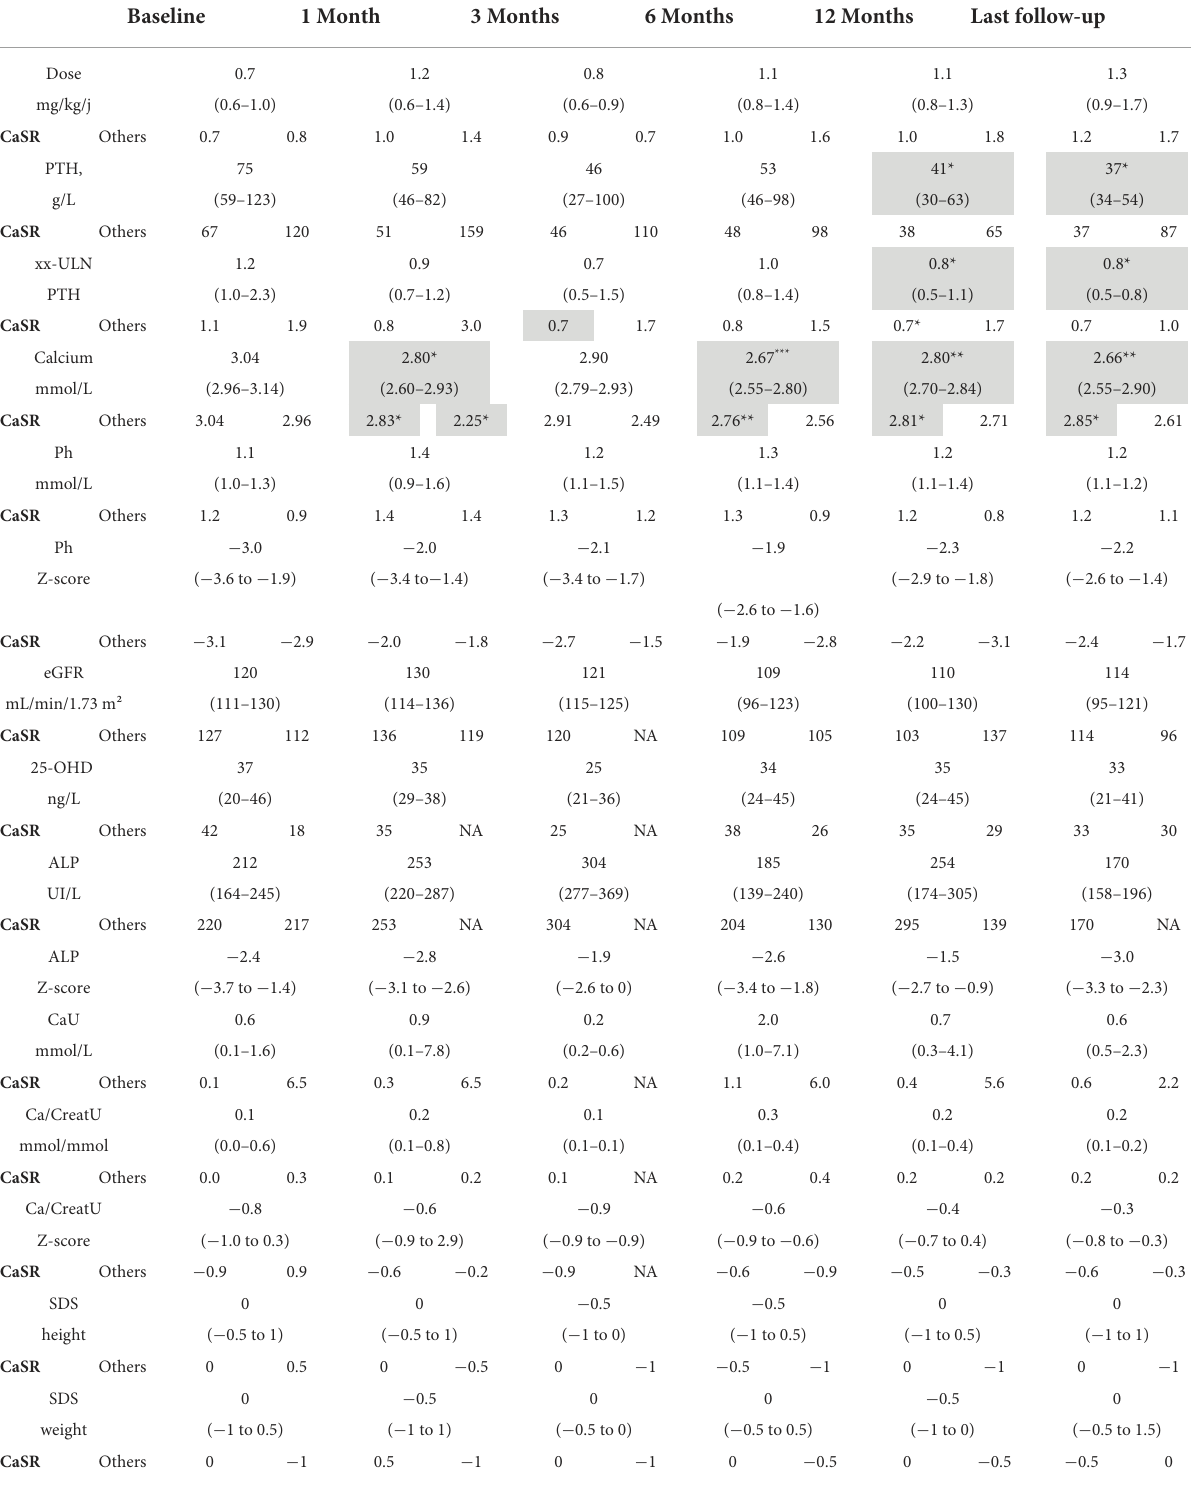
TABLE 3 Summary of the biochemical data available in patients at the different